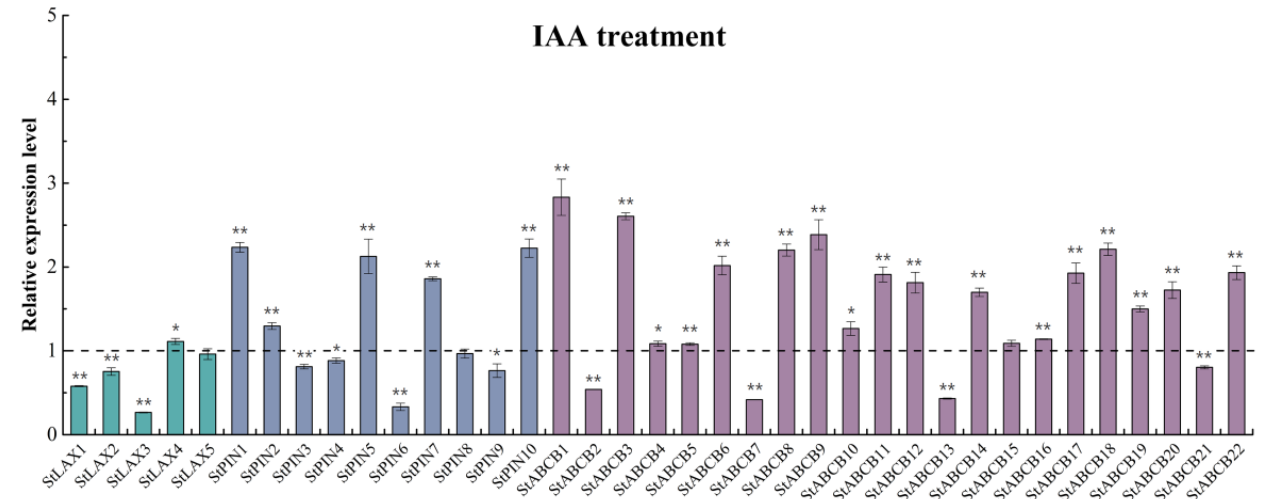
Figure 6. The relative expression values of auxin transporter StLAX, StPIN, and StABCB genes following indole − 3 − acetic acid (IAA) treatment. Total RNA was extracted from four − week − old potato plantlets for expression analysis. The histogram represented the relative RNA level of genes after IAA treatment compared with the mock expression level, which was normalized to a value of 1. The elongation factor 1 − a (ef1 − a) was employed as the internal standard to normalize the relative mRNA level of individual genes. Error bars represent the standard deviations (SDs) from three biological replicates. (* t -test p -value < 0.05, ** t -test p -value < 0.01.)